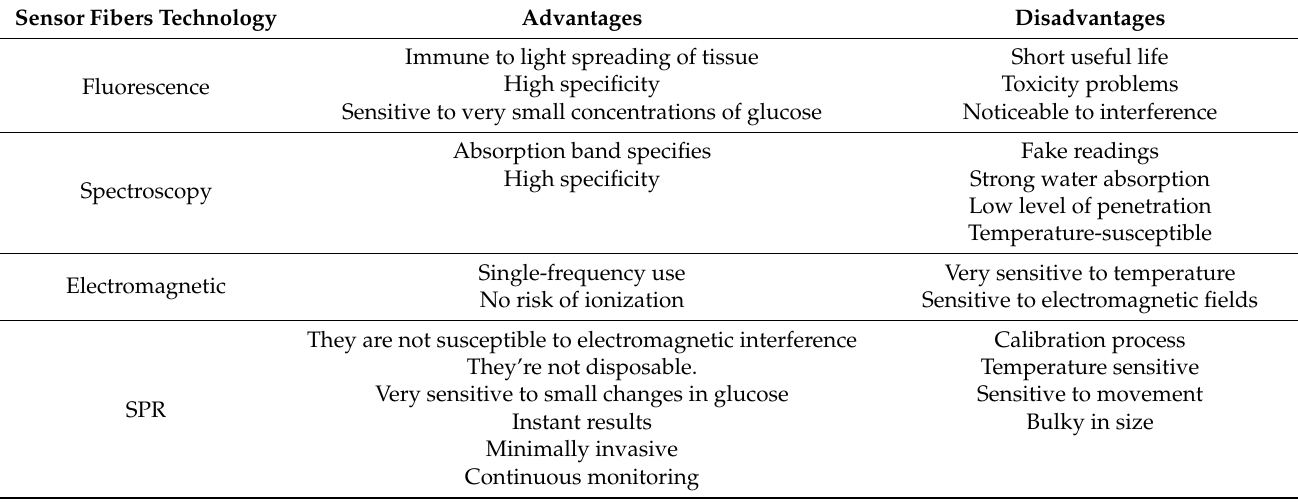
Table 1. Advantages and disadvantages of the optical fiber